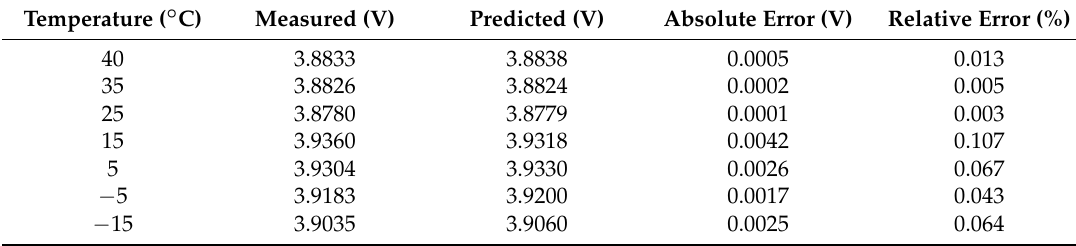
Figure 5. The measured and fitted voltage relaxation results of LCO/MCMB battery (Cell-1) at different SOC points: ( a ) 90%, ( b ) 70%, ( c ) 50%, and ( d ) 30%. It was discharged with 0.25 C at 35 ◦ C. Table 4. Details of the verification results of LCO/MCMB battery at different temperatures. Temperature ( ◦